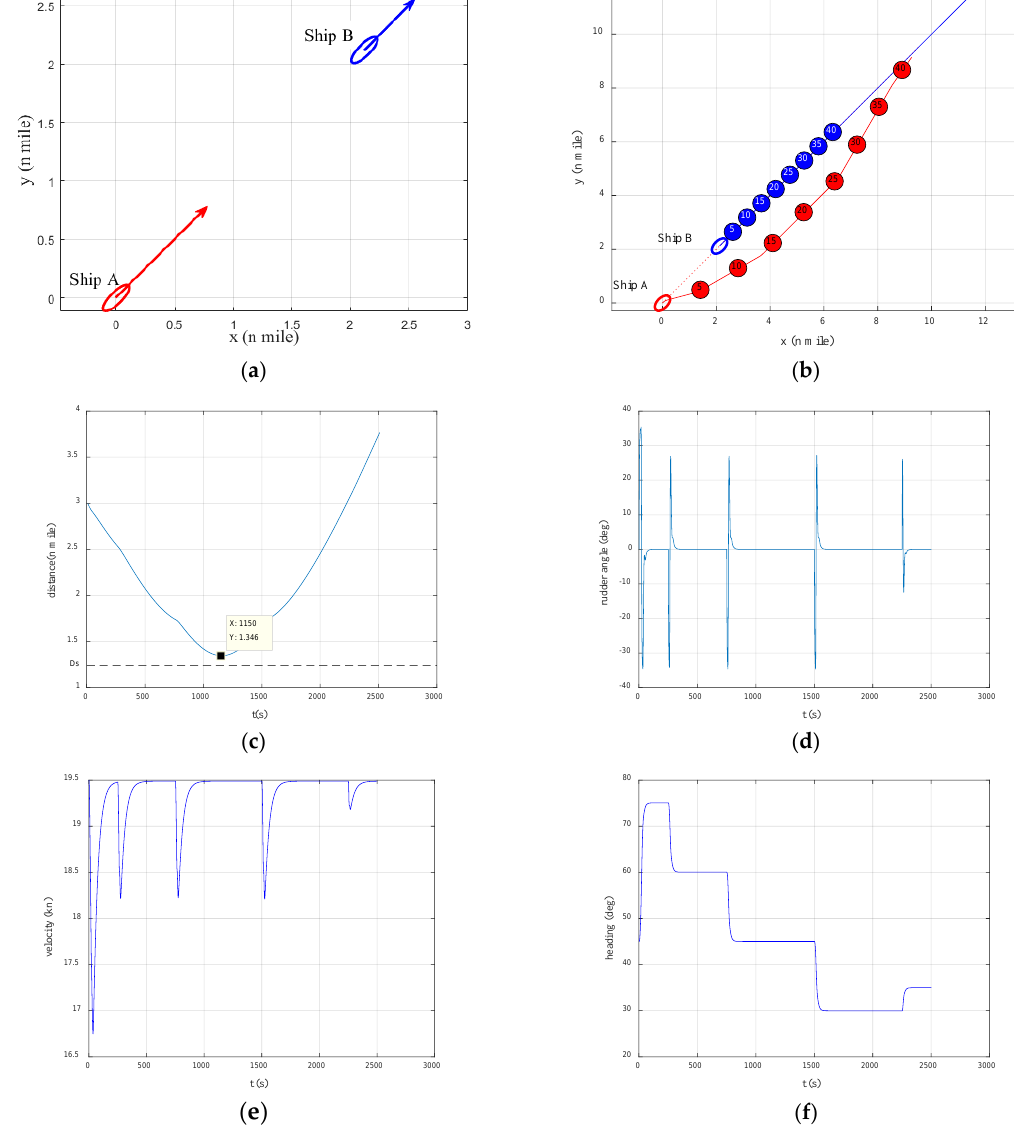
Figure 12. Simulation results for overtaking situations. ( a ) Initial traffic configuration; ( b ) optimal trajectory; ( c ) relative distance; ( d ) rudder angle of ship A; ( e ) velocity of ship A; and ( f ) heading of ship A.